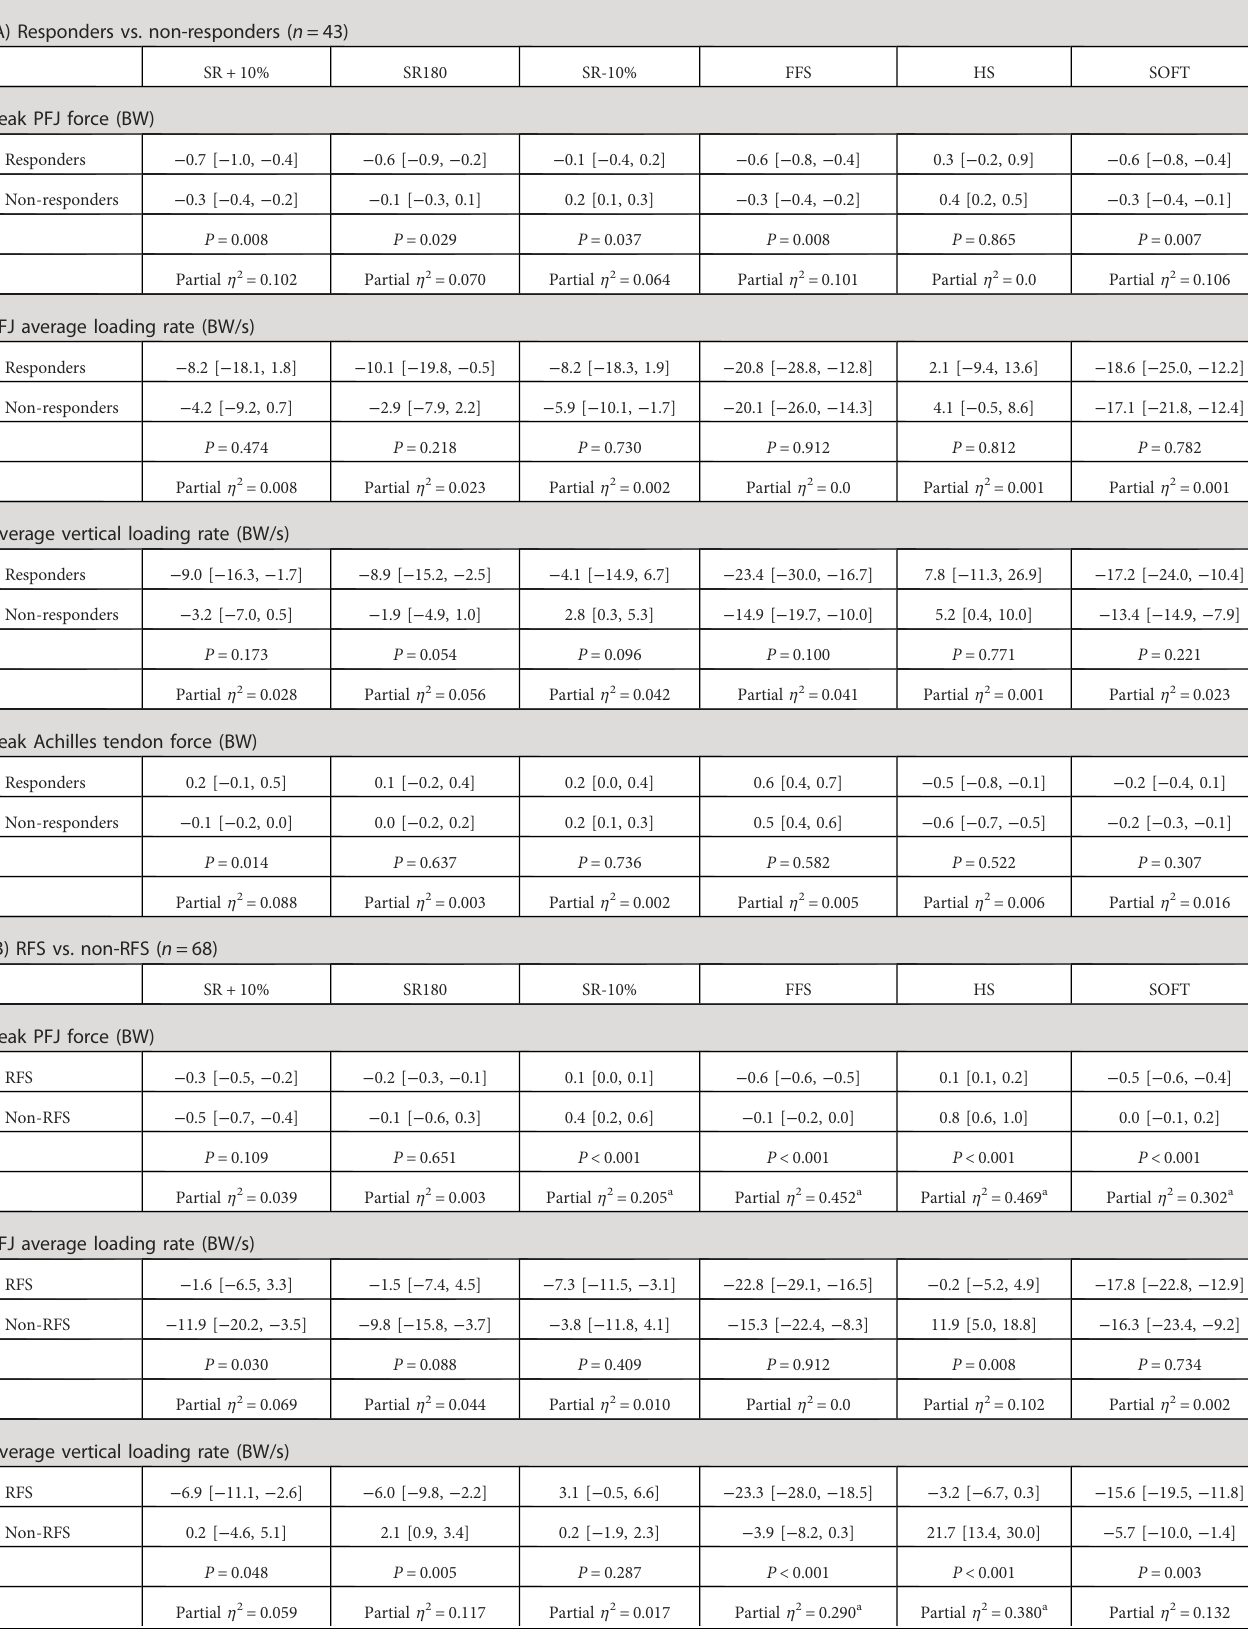
TABLE 3 Comparisons of changes in kinetic variables ( A ) between immediate responders and non-responders to gait modi fi cations, and ( B ) between RFS and non-RFS. Data presented as Mean difference with Normal [95% C.I.], and P -value and effect size for the interaction between mean difference * gait modi fi